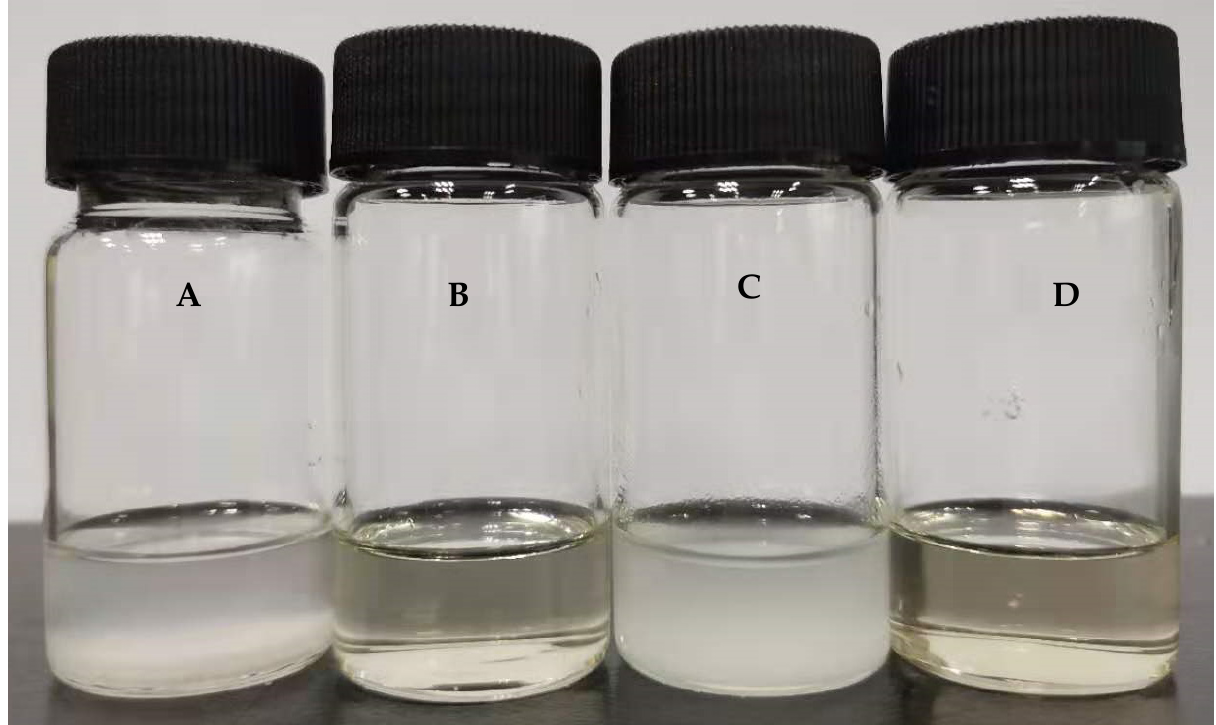
Figure 1. The solubility of heparin ( A ), phospholipids ( B ), physical mixture of heparin and phospholipids ( C ), and heparin–phospholipid (HEP–Pc) complex ( D ) in n -octanol.